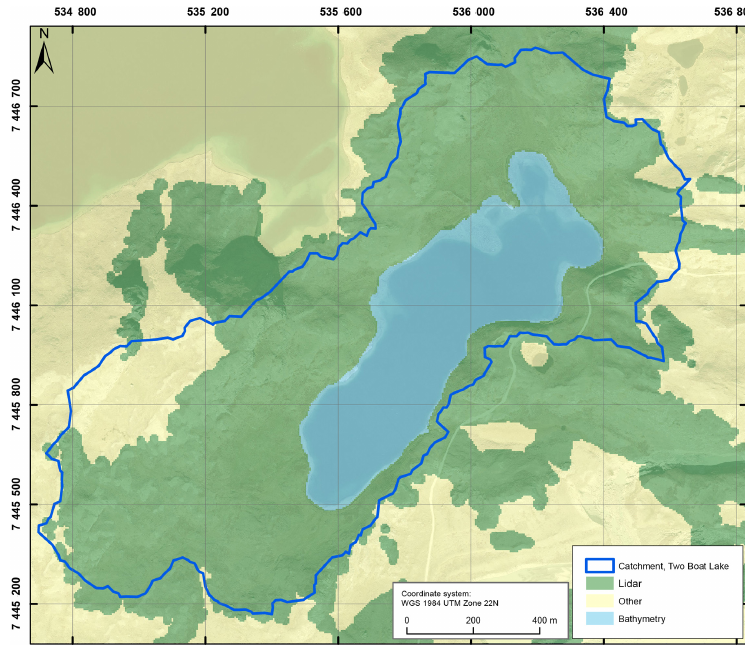
Figure A1. The different data sources used when constructing the digital elevation model of the TBL